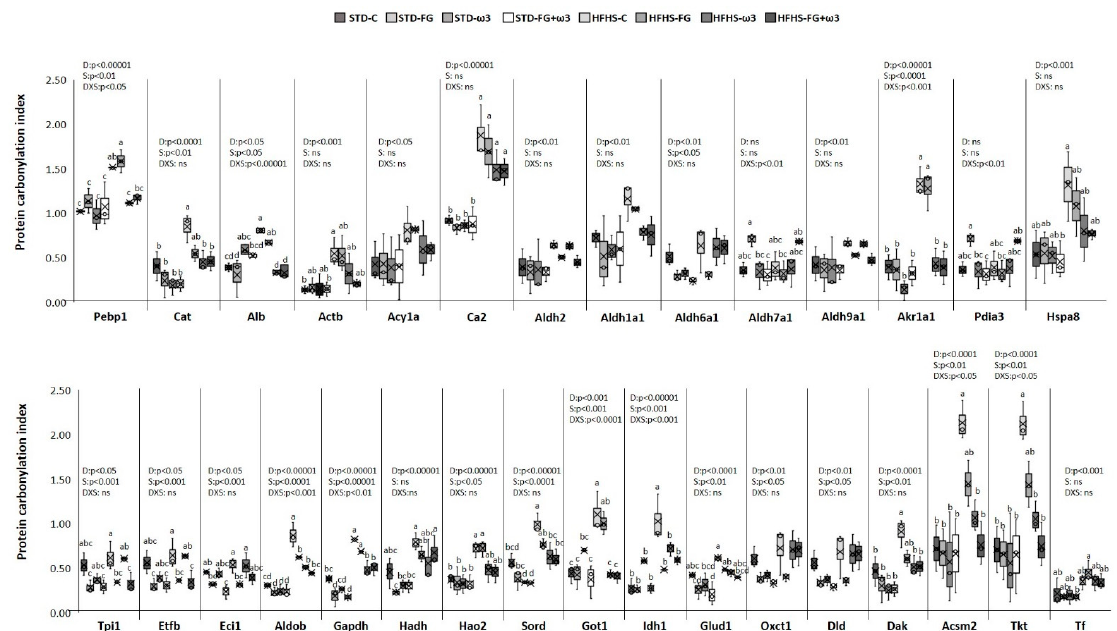
Figure 3. Effects of HFHS feeding and supplementation with fish oil and D-Fagomine on specific carbonylation levels of renal proteins. Results were analyzed by two-way ANOVA for background diet effect (D: STD and HFHS), supplement effect (S: CONTROL, FG, ω -3, FG + ω -3), and interaction between diet and supplement (DxS), followed by Tukey HSD’s post hoc test. Data are presented as means ± SD (n = 9). Different superscripts indicate significant differences ( p < 0.05) (analyzed by post hoc Tukey HSD). ns = no significant.